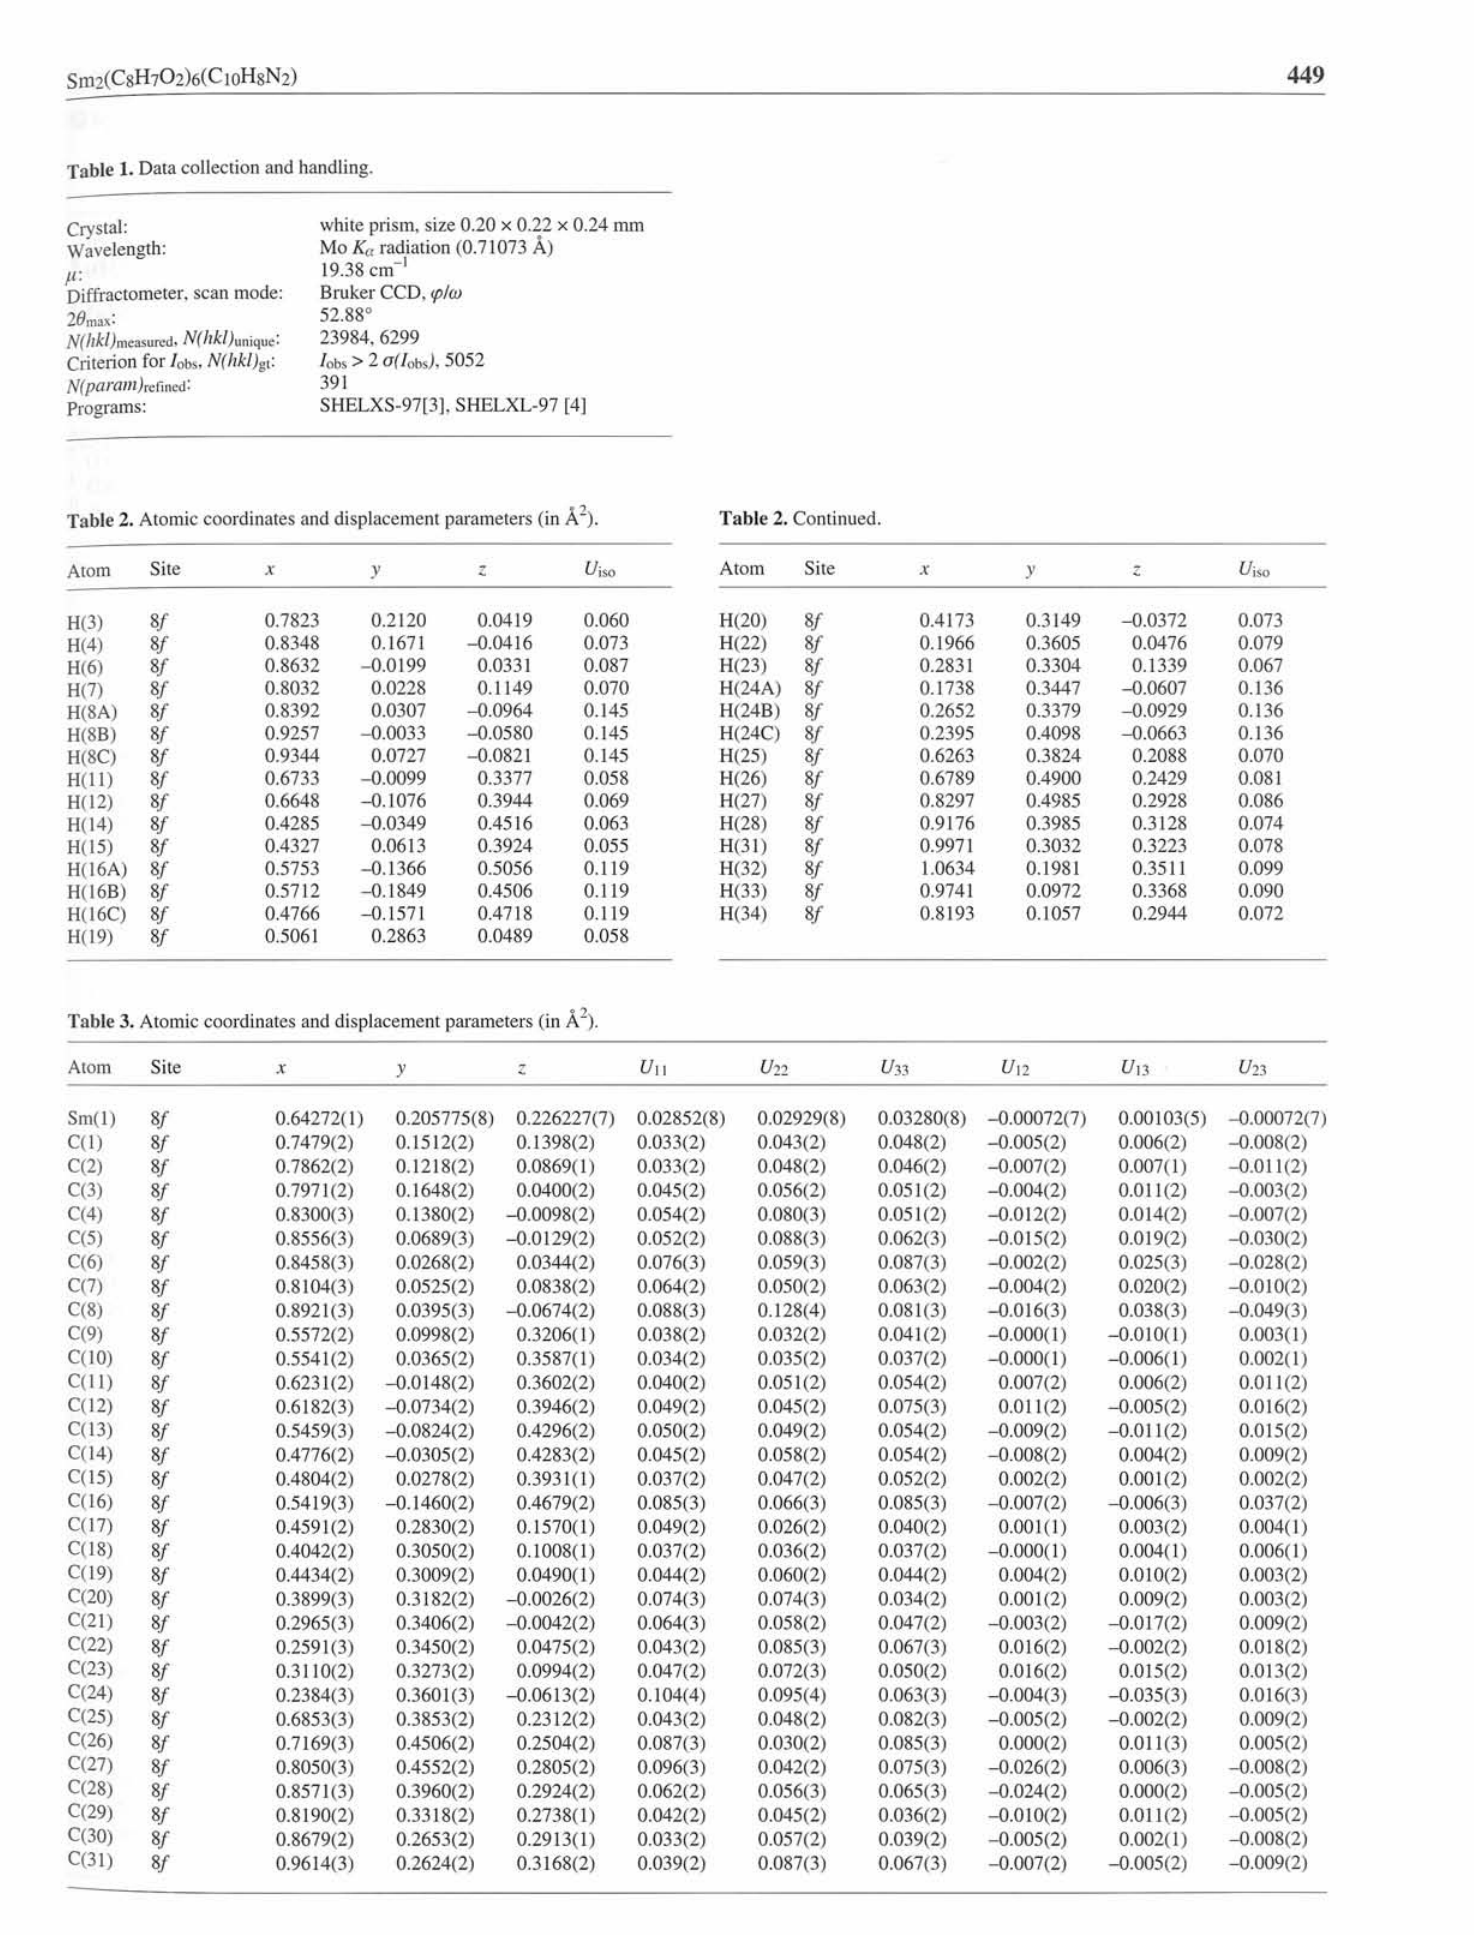
Table 2. Atomic coordinates and displacement parameters (in Â 2 ).